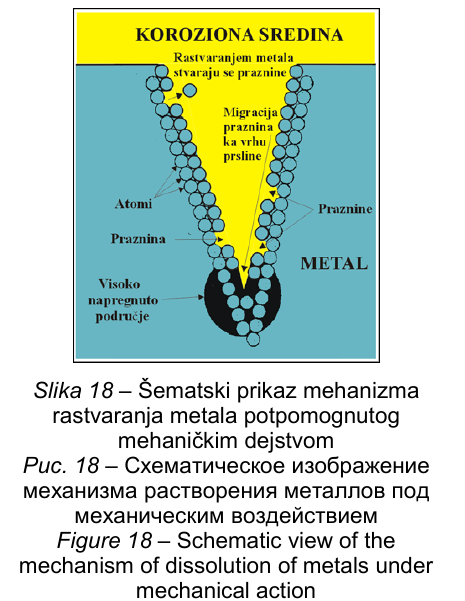
Figure 18 – Schematic view of the mechanism of dissolution of metals under mechanical